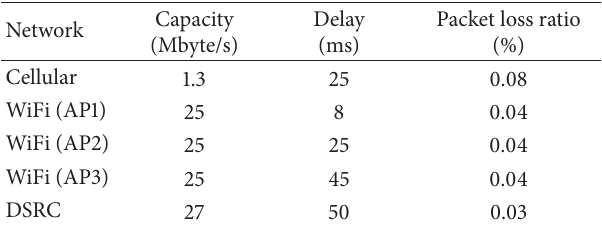
Table 1: Network conditions